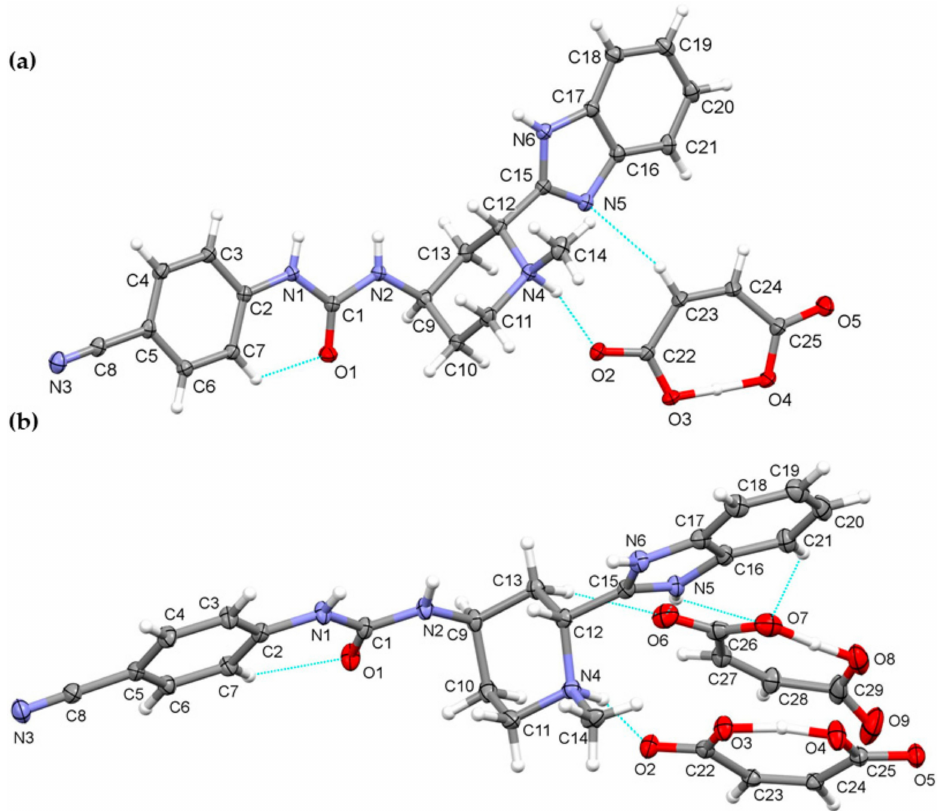
Figure 10. Thermal ellipsoid figures of ( a ) glasdegib monomaleate and ( b ) glasdegib dimaleate drawn at the 30% probability level. The asymmetric unit of glasdegib monomaleate contains one protonated glasdegib molecule and one maleate monoanion. The asymmetric unit of glasdegib dimaleate contains one double-protonated glasdegib molecule and two maleate monoanions. Hydrogen bonds are represented by dashed blue